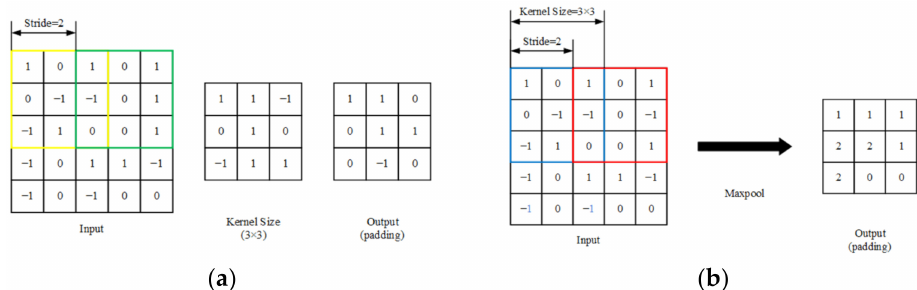
Figure 3. Principle of dimensionality reduction. ( a ) Stride convolution; ( b ) max pooling.